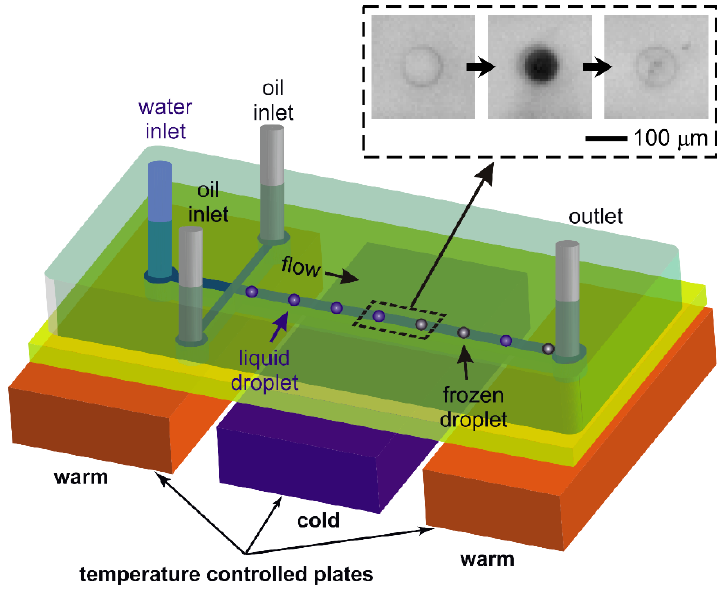
Figure 1. Schematic showing the core design and operation of the LOC-NIPI platform, in which water-in-oil droplets are generated and pass over a cold plate in continuous flow. A portion of the droplet population freezes as the droplets cross the cold plate, with the fraction of the droplets that freeze being dependent upon the temperature of the plate. The warm plates prevent freezing at the inlets and outlet and aid in reproducible droplet generation. The photographs inset show a single droplet freezing as it passes over the cold plate, changing from a colourless circle when liquid to a black circle once ice nucleation has initiated and the dendritic growth of ice has occurred, and finally to a near-colourless circle following full crystallisation to an ice crystal. The time between each photograph is 42 ms.